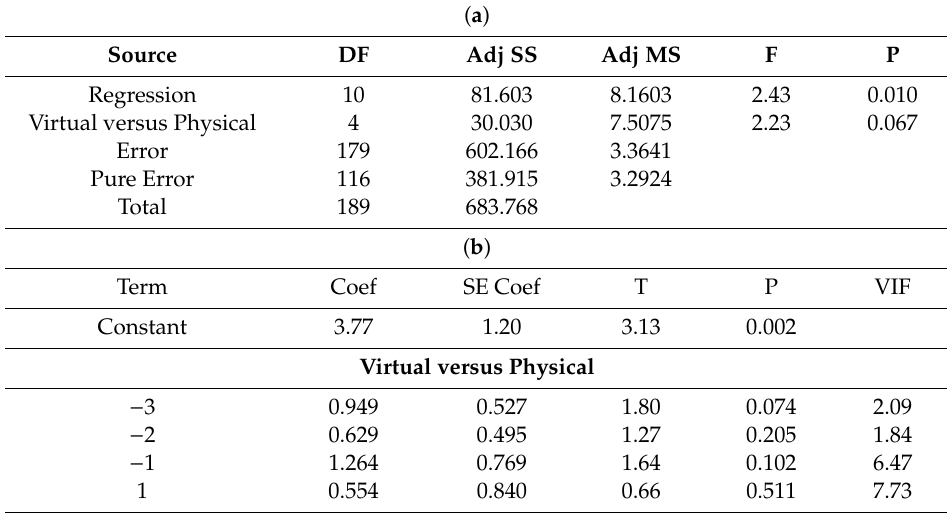
Table 11. ( a ) ANOVA for the arousal construct of the dirt-o ffl oading task with di ff erent feedbacks. ( b ) Comparison of the arousal construct for integrated feedback. ( a